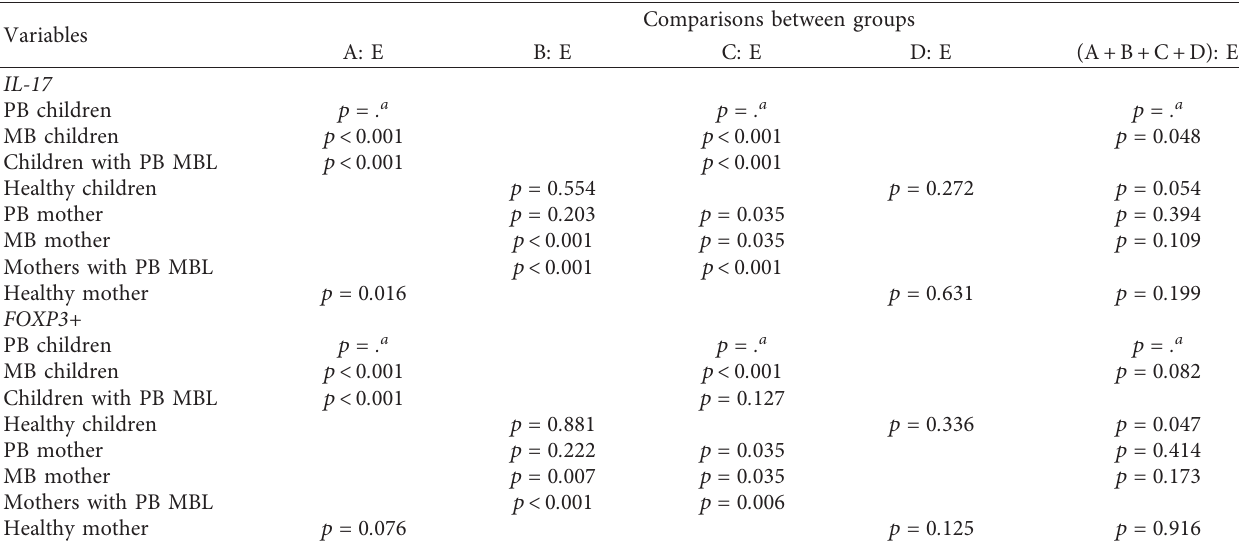
Figure 2: Mean results of IL-17 and FOXP3+ levels. Table 2: The comparisons of p values between